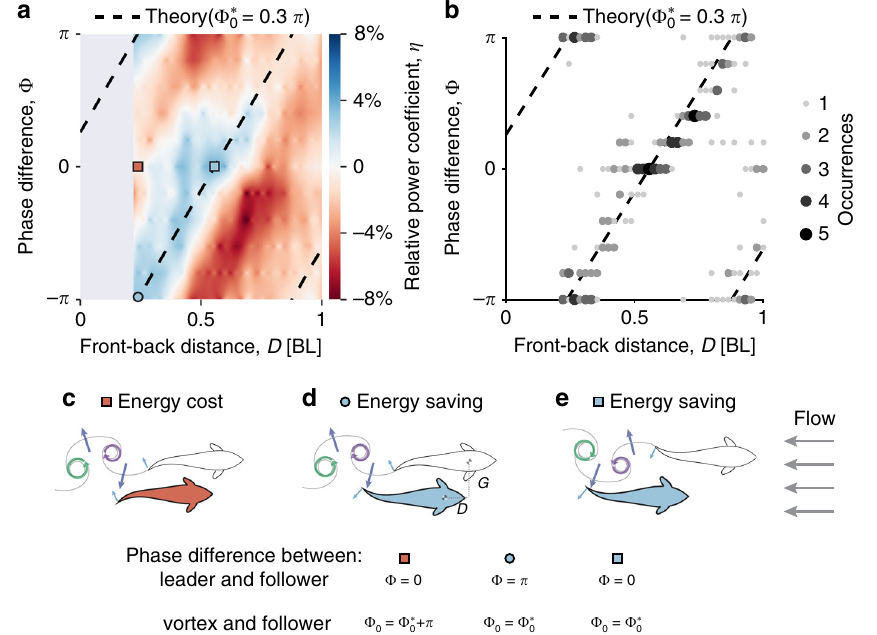
Fig. 2 Robotic fi sh save energy by vortex phase matching (VPM). a Relative power coef fi cient η shown as a function of the phase difference between the leader and the follower Φ and front-back distance D at left – right distance G = 0.31 BL. The dashed line (also in b ) shows the functional relationship described in Eq. (2) that determines the theoretical phase relationship that maximally saves energy (Methods section). Φ (cid:1) is the optimal initial phase 0 difference ( fi tted to the data points of maximum energy saving, as shown in b ). The points marked by red square, blue circle and blue square indicate example cases depicted on panels c – e . b Location of maximal energy saving in the robotic trials. Point size and darkness denote the number of occurrences of each phase difference value at each front-back distance. c – e An illustration of important spatial con fi gurations for vortex phase matching. Energy cost is + π ( c ) or in related to how the follower moves its body relative to the direction of the induced fl ow of the vortices, in the opposite direction with Φ 0 = Φ (cid:1) 0 the same direction with Φ 0 = Φ (cid:1) ( d , e ). Followers interact with the induced fl ow of vortices with the same body phase at any front-back distance (within 0 the range of hydrodynamic interactions), termed vortex phase matching. ( d , e ; Φ 0 = Φ (cid:1) describes the hydrodynamic interaction resulting in energy saving, 0 see description in the text). As the front-back distance changes, the followers must dynamically adopt phase difference Φ , with respect to that of the